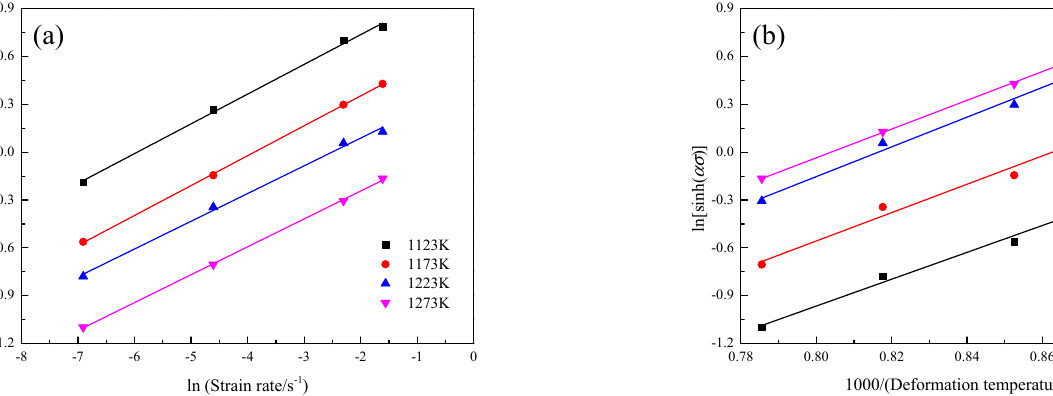
Figure 8. Apparent activation energy for deformation of the GH3230 superalloy double-sheet in hot tensile tests. 3.5. Constitutive Models 3.5.1. Johnson-Cook (JC) Model The JC model can be expressed as follows.